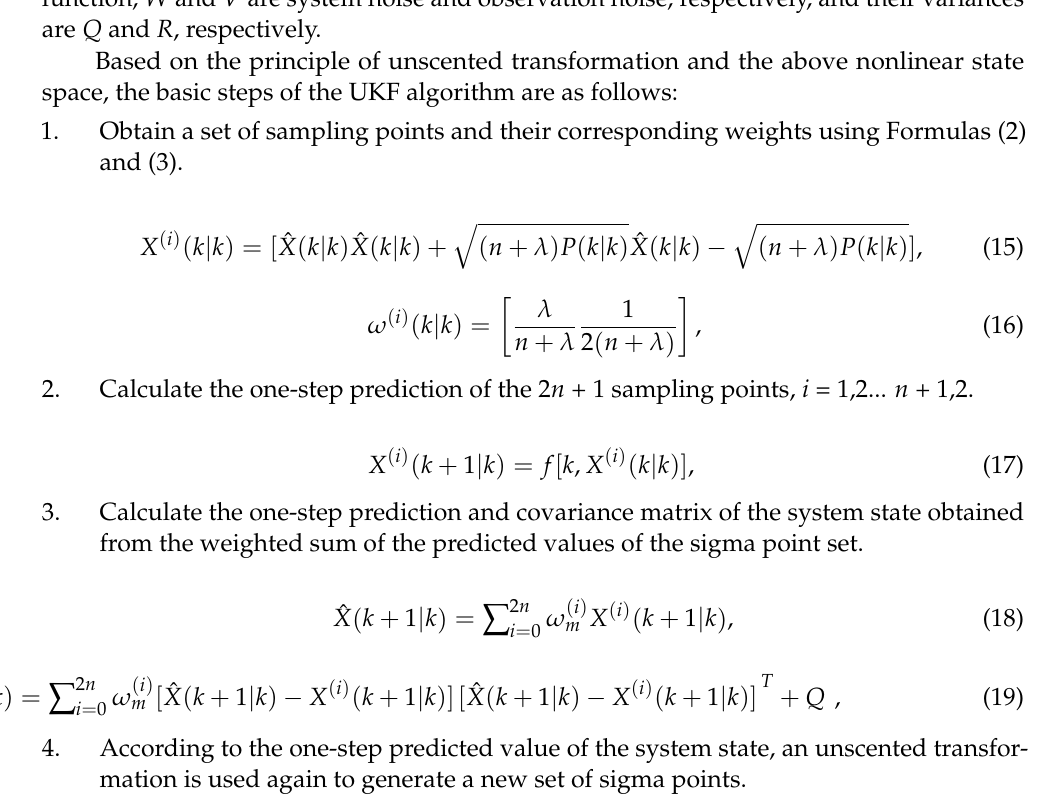
According to the one-step predicted value of the system state, an unscented transfor- mation is used again to generate a new set of sigma points.